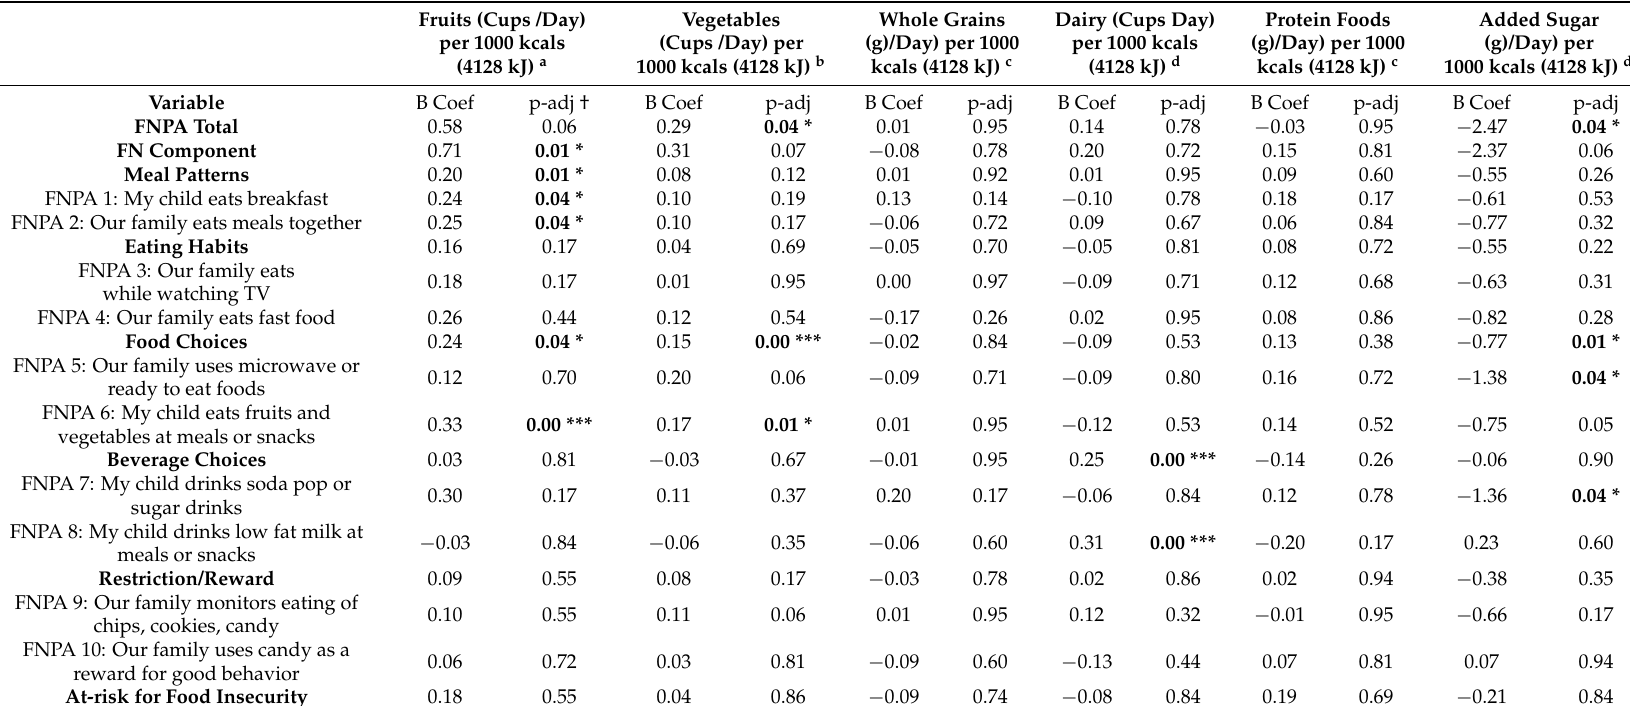
Table 4. Multivariable linear regression examining associations between FNPA factors and at-risk for food insecurity with dietary intakes ( n =